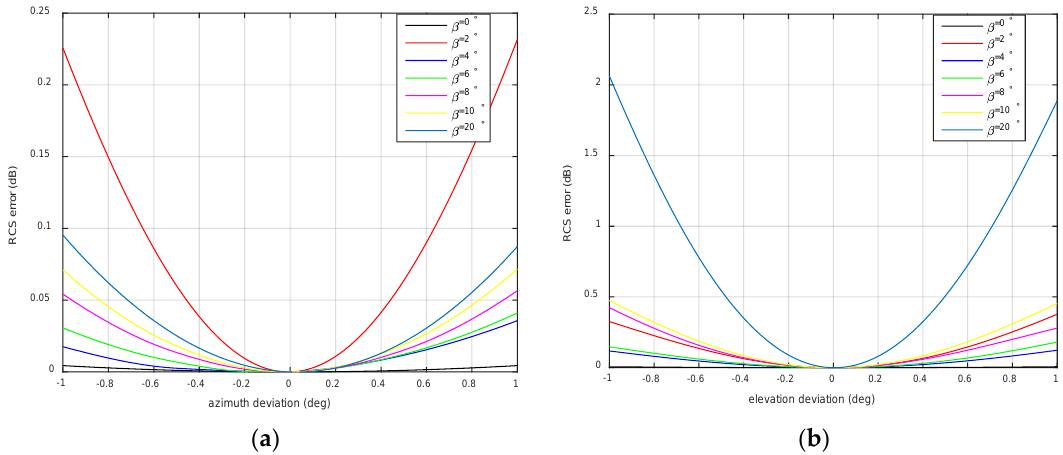
Figure 12. The effect of pointing deviation on the RCS at different bistatic angles. ( a ) Azimuth pointing deviations and corresponding RCS errors; ( b ) elevation pointing deviations and corresponding RCS errors.